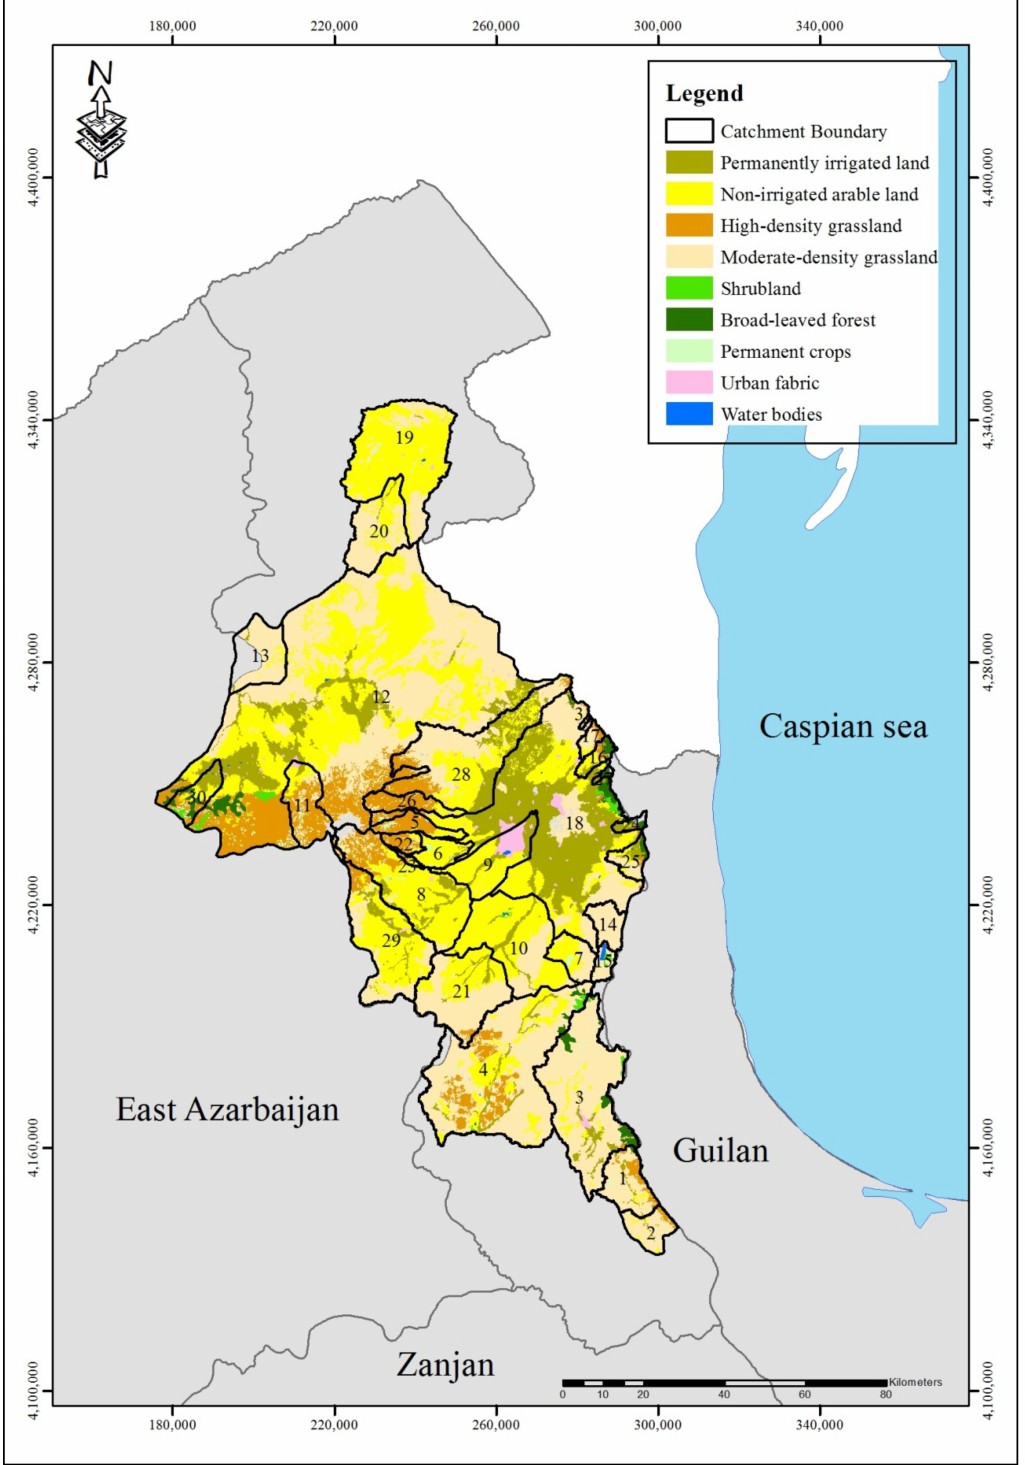
Figure 1. Location of the study